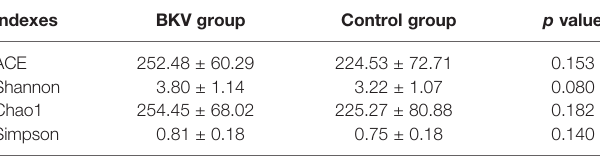
TABLE 2 | Microbial diversity in the BKV group and the control